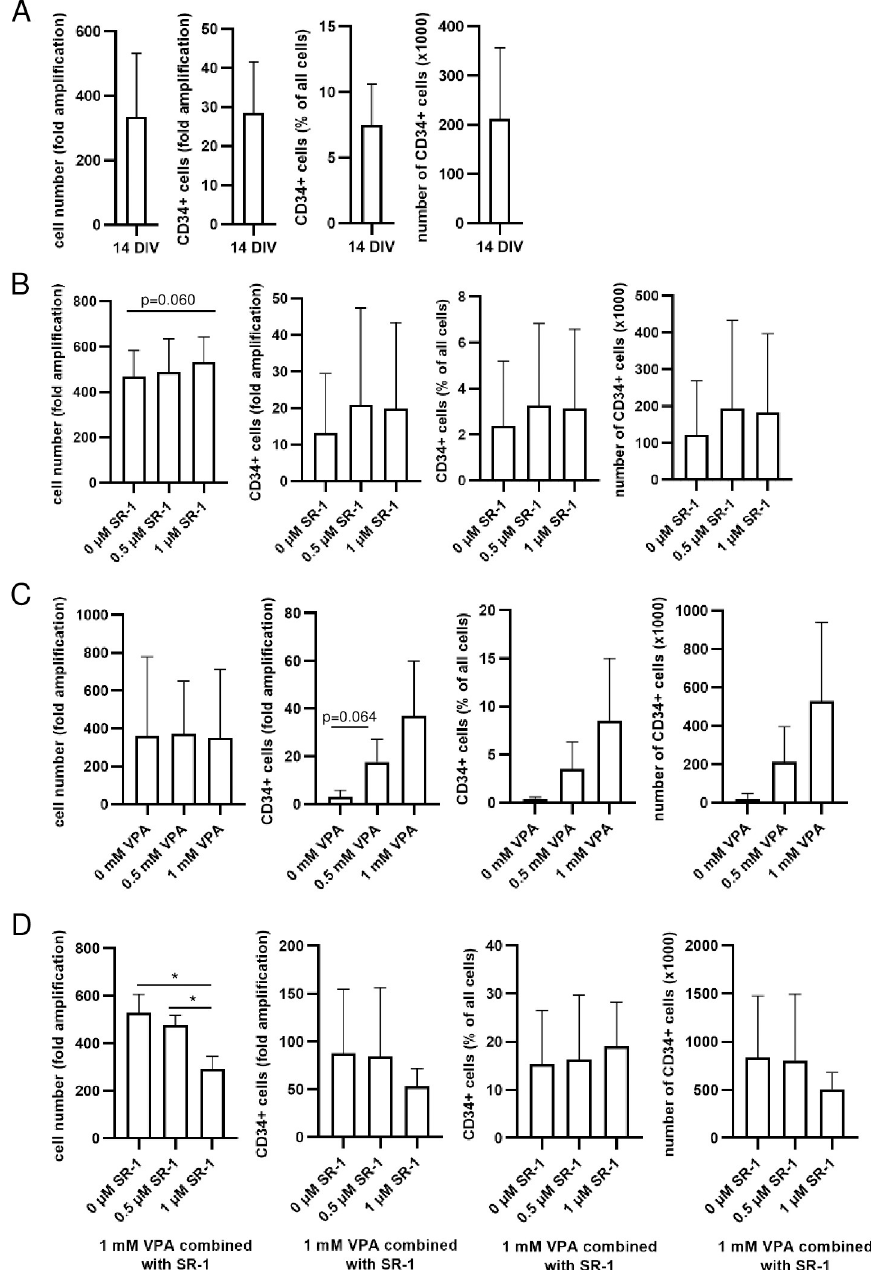
Fig 1. Valproic acid (VPA) and Stemreginin-1 (SR-1)-dependent effects on the growth of human hematopoietic stem cells (HSCs) in vitro . Human HSCs were cultured in Stemline II Hematopoetic Stemcell Medium supplemented with 100 ng/ml FLT3, 100 ng/ml SCF, 100 ng/ml TPO and 50 ng/ml IL-3 (HSC medium). CD34+ cells were determined by flow cytometric analyses using an anti-CD34/CD45 mouse monoclonal antibody and 7AAD. (A) Fold amplification of all cells, CD34+ cells as well as percentage and absolute cell number of CD34+ cells after 14 days in vitro (DIV) are depicted for three different donors as their mean ± SD. HSCs were treated with 0.5 or 1 μ M SR-1 (B), 0.5 or 1 mM VPA (C) or with 1 mM VPA in combination with 0.5 or 1 μ M SR-1 (D) for 14 DIV are depicted for three different donors as their mean ± SD. � p <